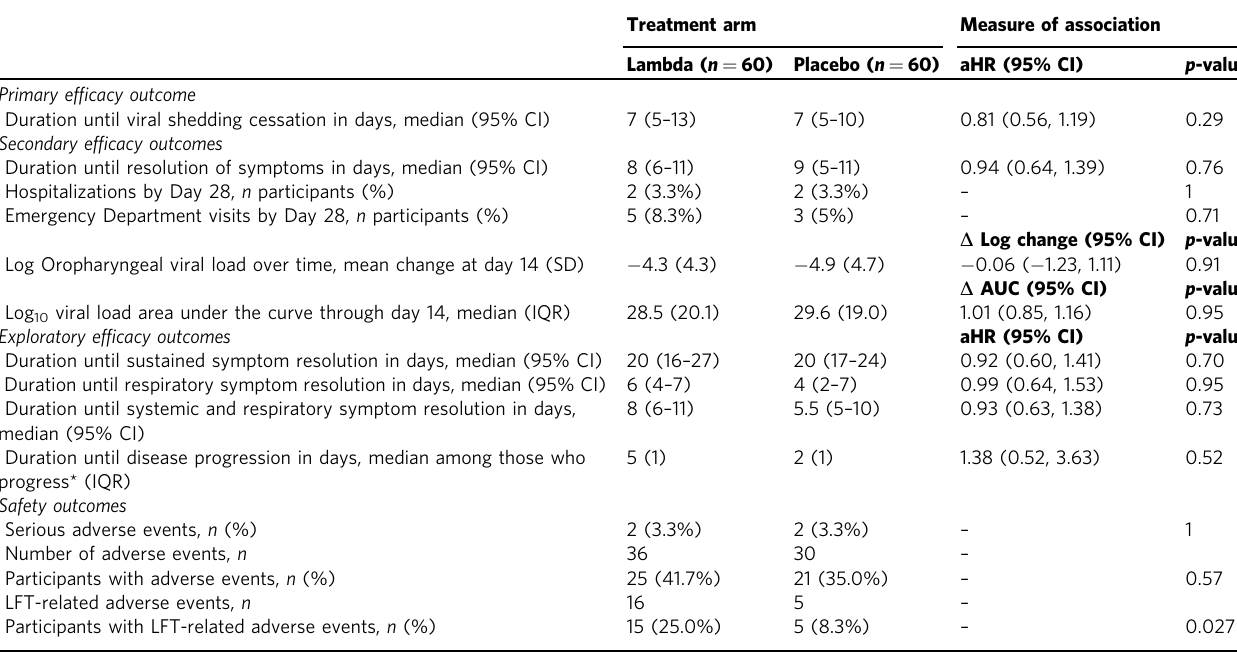
Table 2 Ef fi cacy and safety